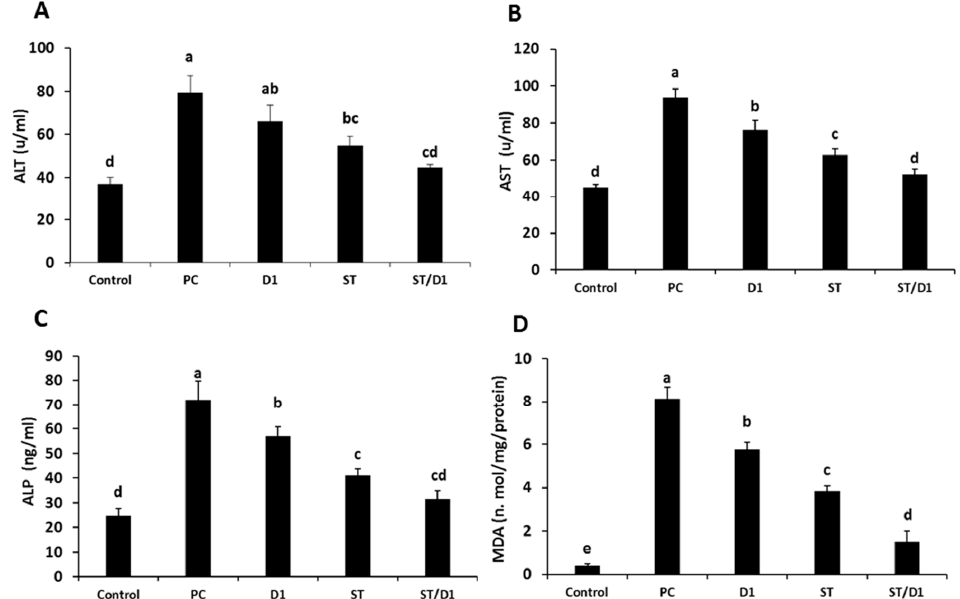
Figure 3. The effect of the treatment groups (Control, Cisplatin (P.C.), Cisplatin + GGE (D1), Cisplatin + BM-MSCs (St), Cisplatin + BM-MSCs + GGE (St/D1)) on the renal functions in rats, ( A ) ALT and ( B ) AST; ( C ) ALP and ( D ) MDA. Different alphabetic letter/s being significantly different ( p < 0.05). Table 2. The effect of the treatment groups (Control, Cisplatin, Cisplatin + GGE, Cisplatin + BM- MSCs, and Cisplatin + BM-MSCs + GGE) on the SOD and GSH level in rats. Different alphabetic letter/s being significantly different ( p < 0.05).